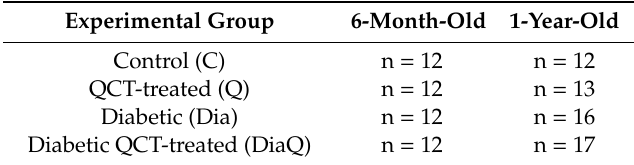
Table 3. Summary of the number of animals (rats) in experimental groups.